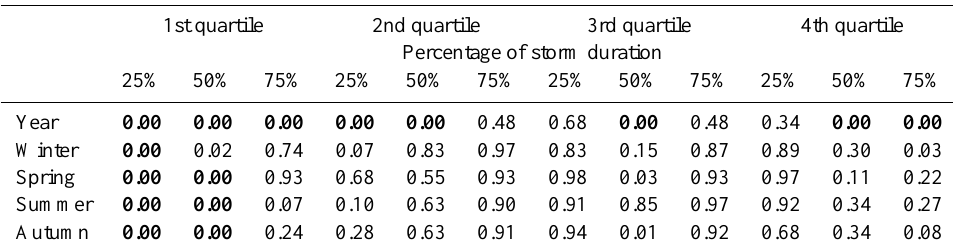
Fig. 4. Huff curves for different quartile storms and different seasons. The 10%, 50% and 90% percentile curves are given by, respectively the dashed, full and dotted lines. Table 3. Statistical comparison of Huff curves for different thresholds of T SEC (0.04, 0.08, 0.12, 0.16, 0.20 and 0.24 year) and different seasons. The p-values for the different non-parametrical Anderson-Darling 6-sample tests are given. Significant differences of Huff curves at a significance level of 1% are indicated in